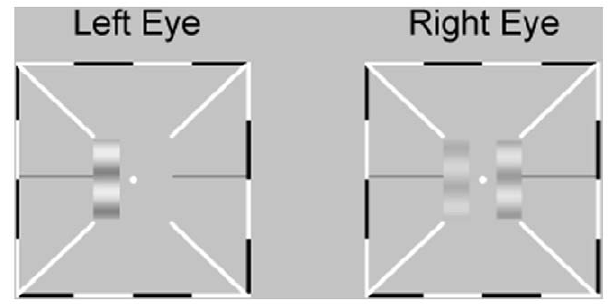
Figure 1. Stimulus display. The two panels were delivered to the left and right eyes using a stereoscope. The two test gratings on the left in the two eyes’ views, differing in contrast and phase, are combined via stereoscope. Observers adjusted the contrast and phase of the monocular probe grating to match those of the cyclopean image.